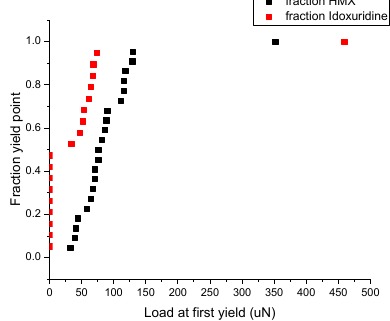
Figure 3. Cumulative fraction of yield behavior for HMX and idoxuridine. While the mean load at yield for indentations that did exhibit a distinct yield point was statistically similar (93 and 98 μ N for HMX and idoxuridine, respectively), the materials exhibit different behavior in yield distribution. While all indentations in HMX showed a yield point, only half the indentations in idoxuridine showed.